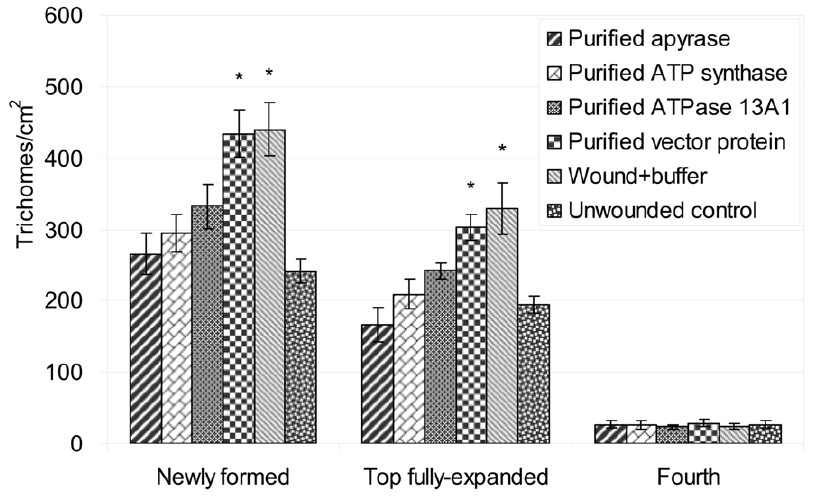
Figure 5. Trichome productions in tomato leaves after 10 days of different treatments. Values are expressed as mean 6 SE (n=5). Asterisks indicate statistical difference determined by ANOVA analysis followed by the Duncan’s Multiple Range Test (P , 0.05).